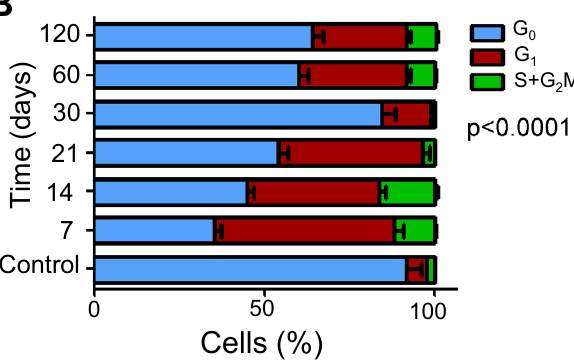
Figure 3. Cell cycle analysis of the SCs. ( A ) Representative dot-plots/histograms show the gating strategies followed for sorting of SCs (CD45 − CD34 + phenotype) and the subsequent cell cycle analysis based on DNA and RNA quantification through Hoechst 33342 and Pyronin Y staining. ( B ) Bar diagrams represents the distinct phases of cell cycle of the SCs with respect to specific stage of injury. Data were presented as mean ±